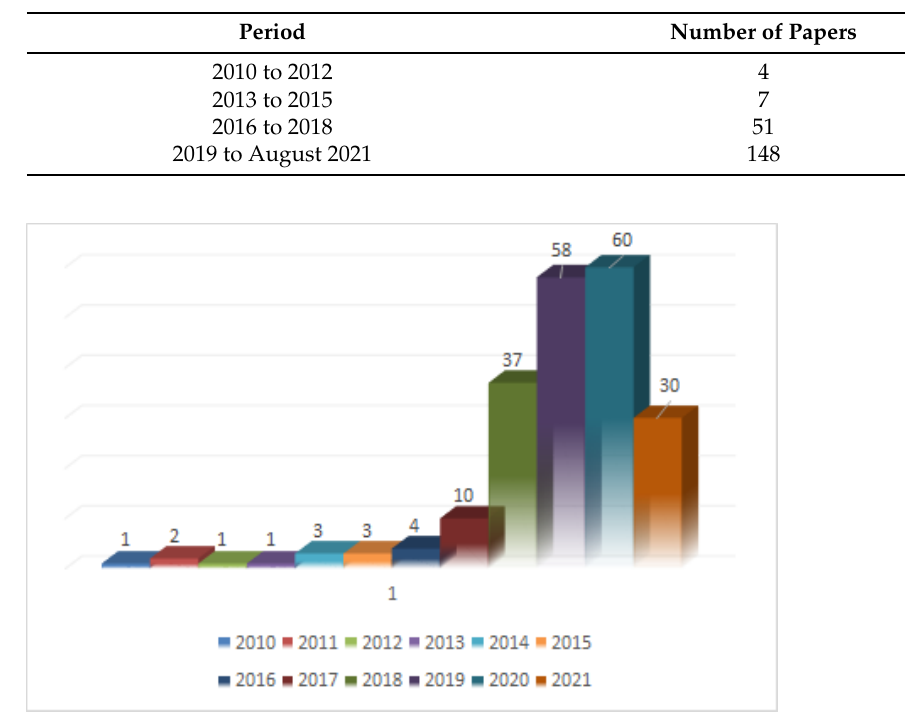
Figure 3. Number of papers from 2010 to 2021.